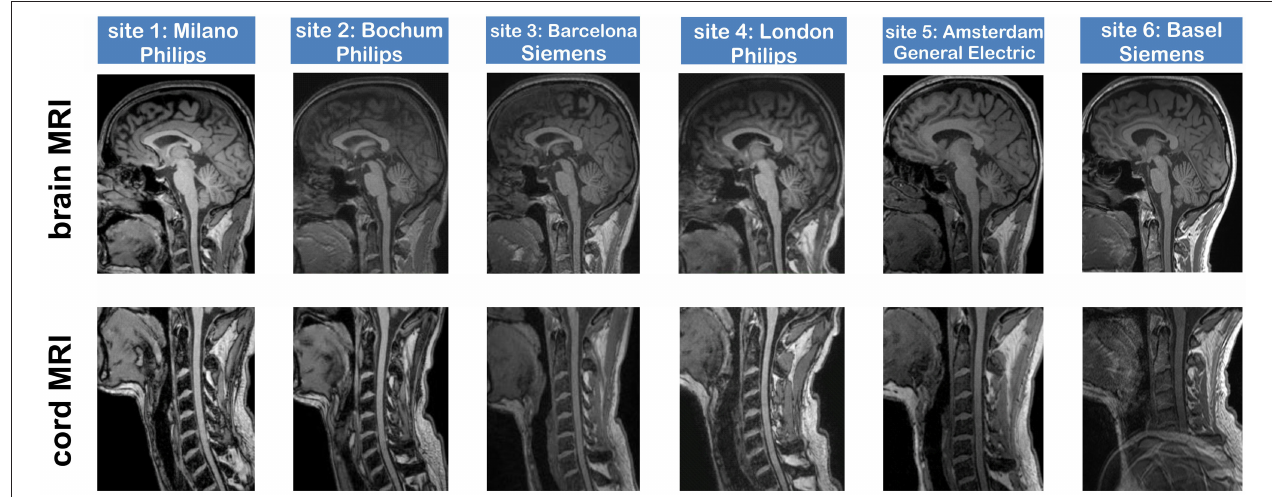
FIGURE 2 | Image quality of 3D T1-weighted brain and spinal cord sequences at six 3-Tesla MRI scanners, acquired in the same healthy volunteer at all sites (age 45 years at first examination; male).